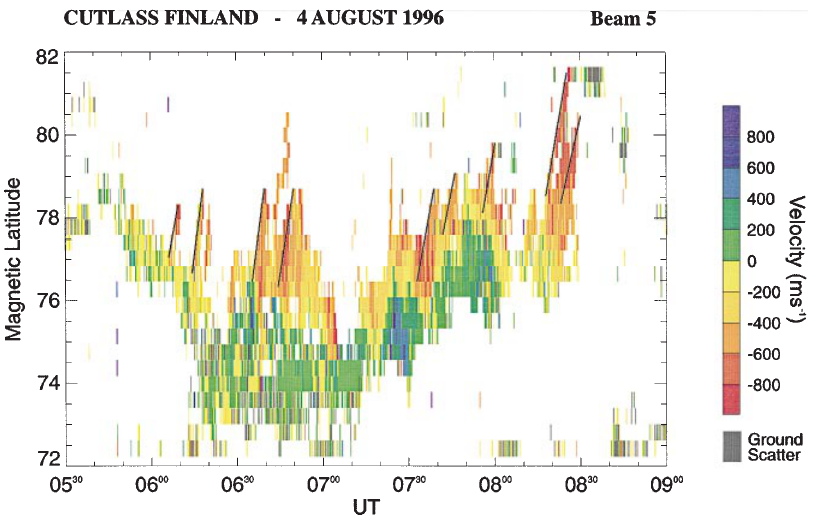
Fig. 2. Latitude-time-velocity (LTV) plots for beam 5 of the CUTLASS Finland radar, between 0530 and 0900 UT on the 4 August 1996. The Doppler velocity is colour-coded with positive velocities indicating motion towards the radar and negative velocities away from the radar. Overplotted black lines trace the motion of some of the individual transients